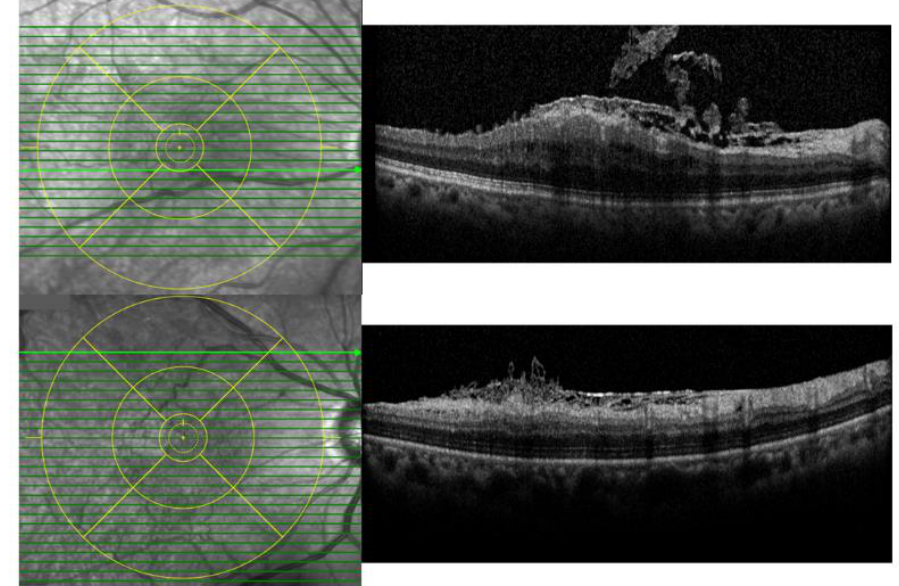
Figure 1. Representative images of internal limiting membrane (ILM) dehiscence with retinal nerve fiber layer schisis. The upper row shows ILM dehiscence within the inner circle of Early Treatment of Diabetic Retinopathy Study (ETDRS) and the lower row shows ILM dehiscence outside the inner circle of ETDRS.